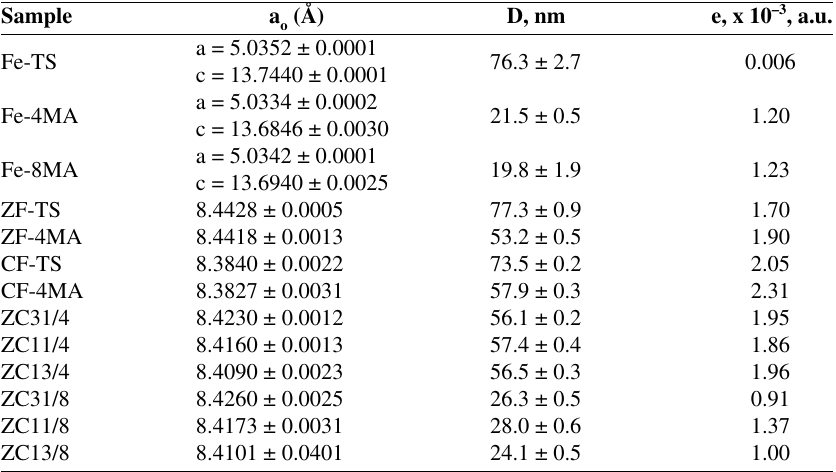
), average crystallite size (D) and lattice strain (e). o